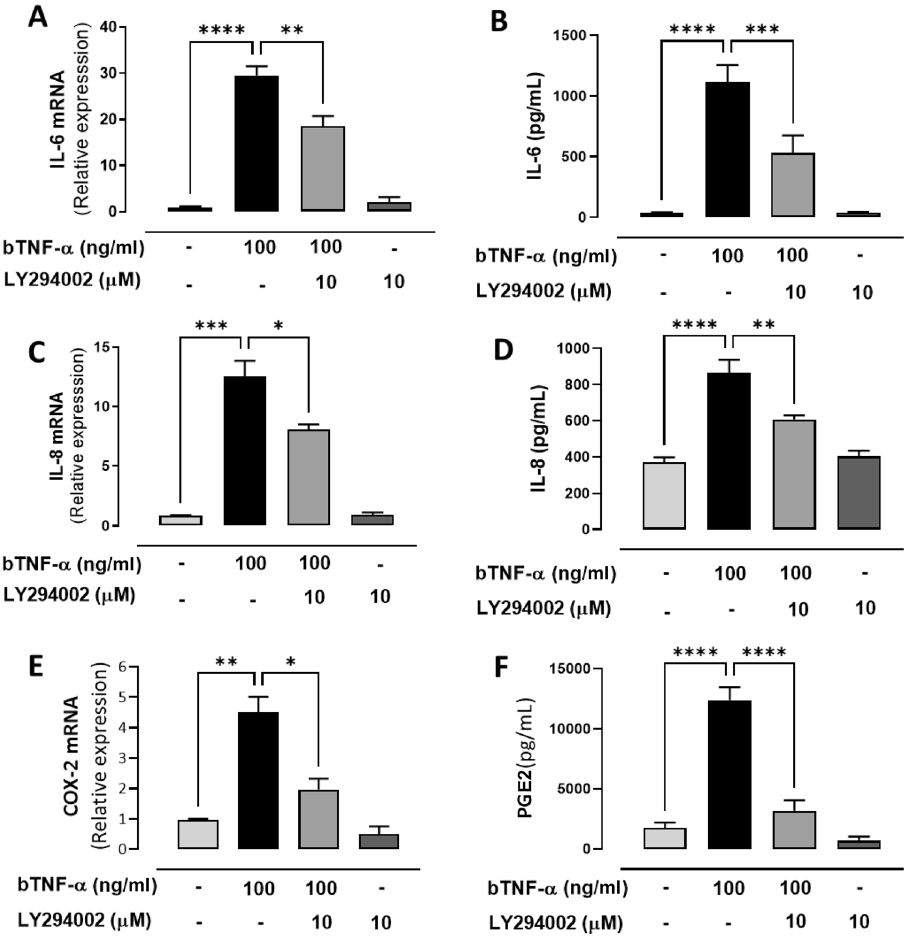
Figure 5. The PI3K/Akt pathway is involved in the expression of IL-6, IL-8 and COX-2/PGE2 in bFLS induced by bTNF-α. mRNA expression and production of IL-6 ( A , B ), IL-8 ( C , D ), and COX-2 ( E )/PGE2 ( F ) in bFLS treated or not with LY294002 and stimulated or not with bTNF-α. **** p < 0.0001; ***0.001; ** p < 0.01, and * p < 0.05 with respect to bTNF-α. Each bar represents the mean ± SEM, n = 4 independent